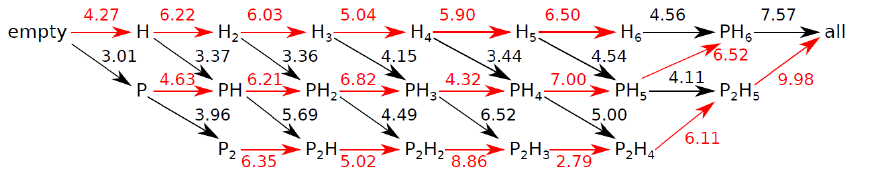
Figure 6. Released energy (in kcal/mol) after the occupation of a P ( black arrows) or H ( red arrows) cage of sI CO 2 @H 2